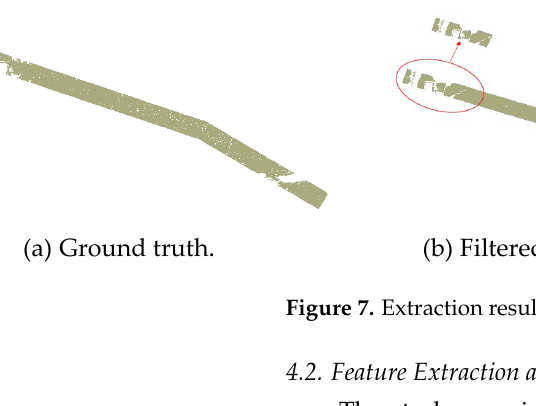
Figure 7. Extraction result of the ground point cloud.